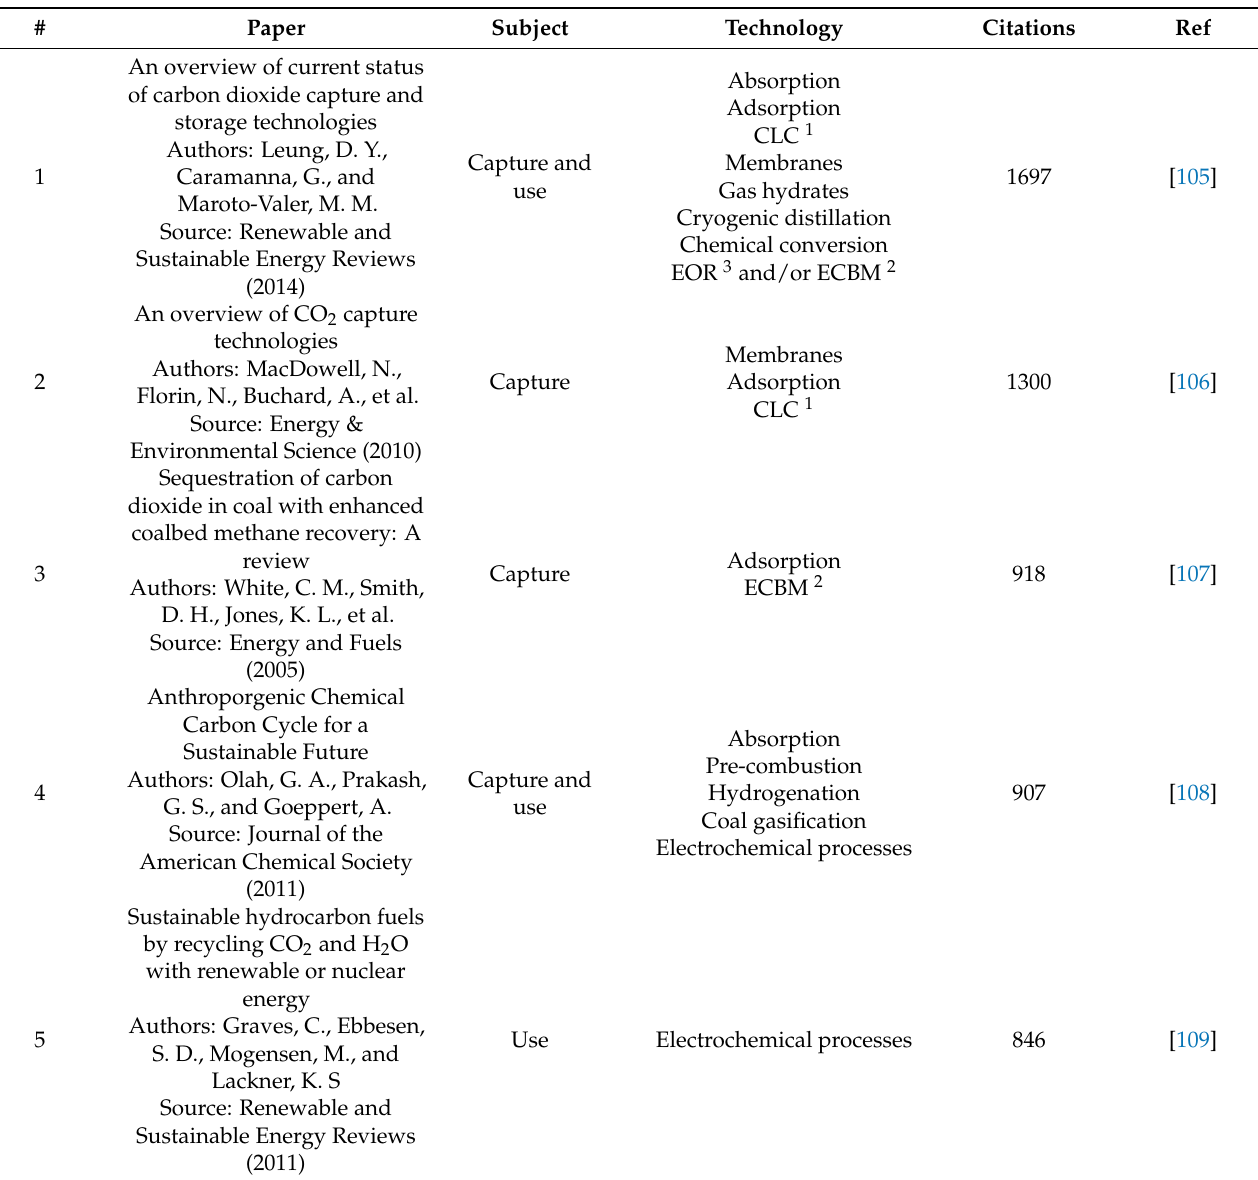
Table 7. Top five most cited review papers associated with the scope of the present